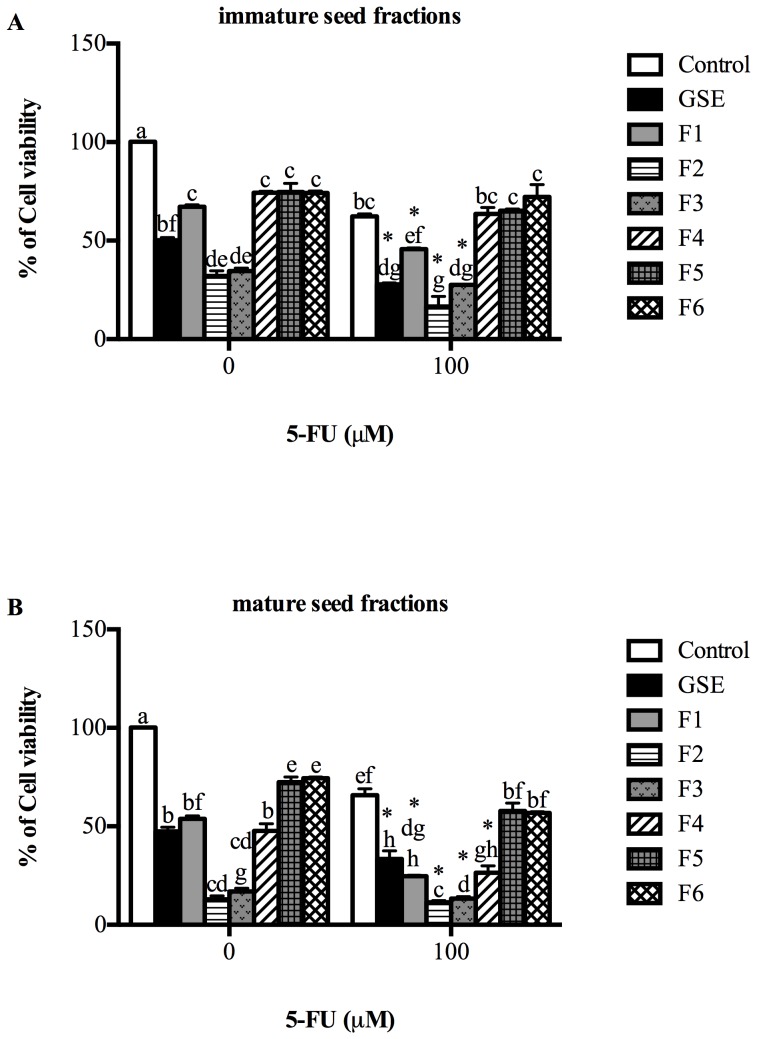
Combined effects of immature (A) and mature (B) fractions and 5-FU on Caco-2 cells for 72 hr measured by 3-(4,5-Dimethylthiazol-2yl)-2,5-diphenyl-tetrazolium bromide (MTT) assay.Data are presented as percentage of cell viability relative to viability of control cells. Data are expressed as mean ± SEM of 3 independent experiments. Statistical analysis was determined by two-way ANOVA with Tukey'spost-hoc test. Values with different letters (a,b,c) in each column were statistically different at P<0.05. * indicates significant difference in 5-FU treated group when compared to 5-FU control.